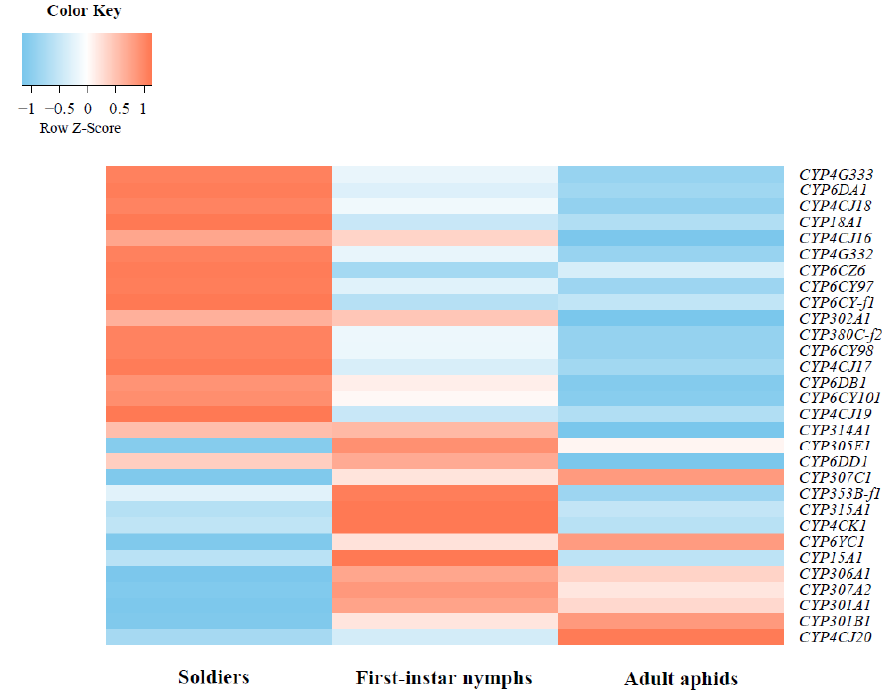
Figure 5. Expression patterns of P450 genes in soldiers, first-instar nymphs, and adult aphids of Pseudoregma bambucicola. Pseudoregma bambucicola